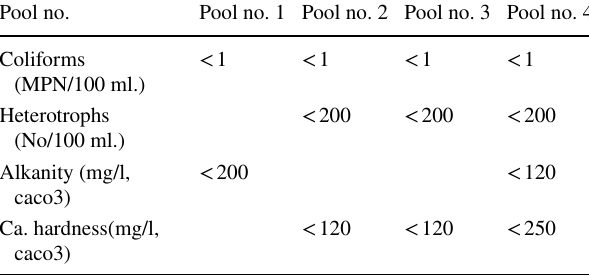
Table 4 Microbial and chemical quality of the pools water Pool